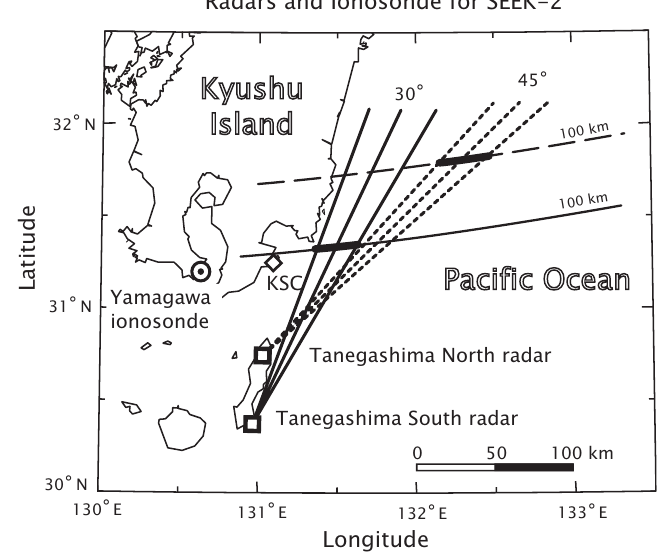
Fig. 1. Experimental setup showing the ionosonde and VHF radar locations and observing